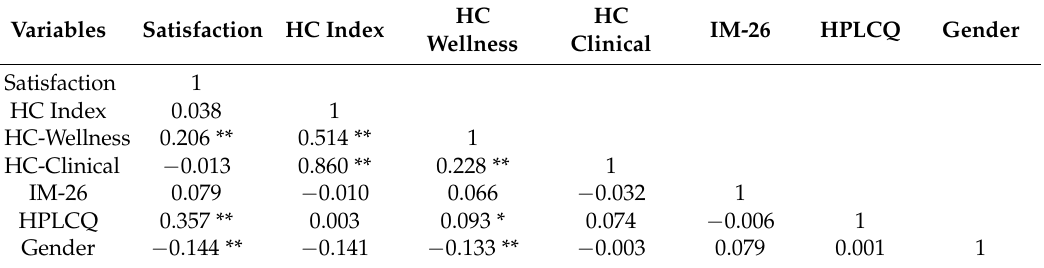
Table 4. Pearson’s product moment correlations for life